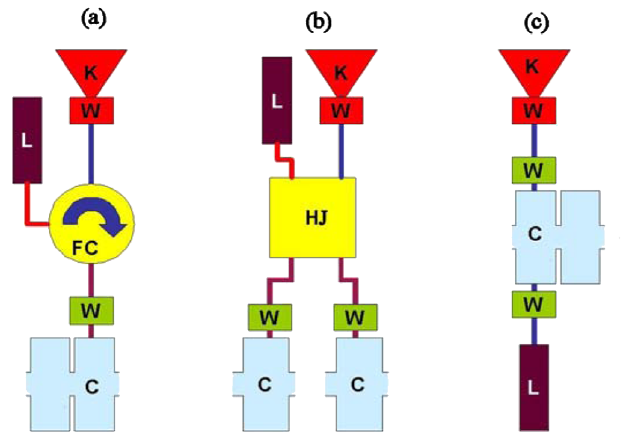
FIG. 3. (Color) Different design options for the RFD (K is the klystron; FC is the ferrite circulator; L is the load; HJ is the hybrid junction; C is the SW cavity; W is the vacuum tight